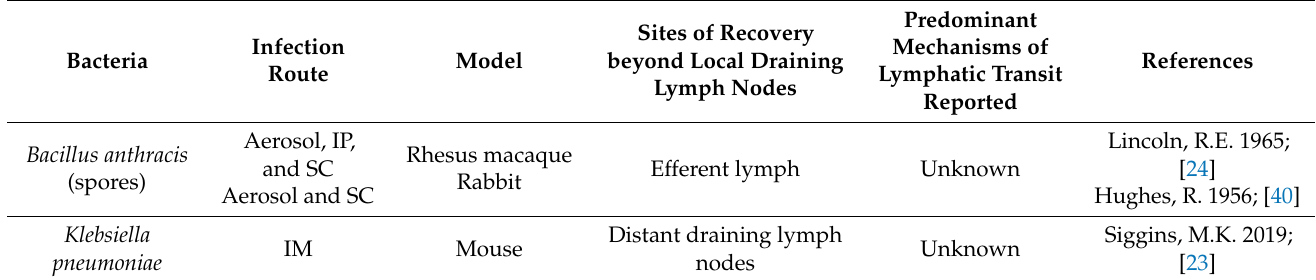
Table 2. Studies demonstrating recovery of bacteria from the lymphatic system beyond local draining lymph